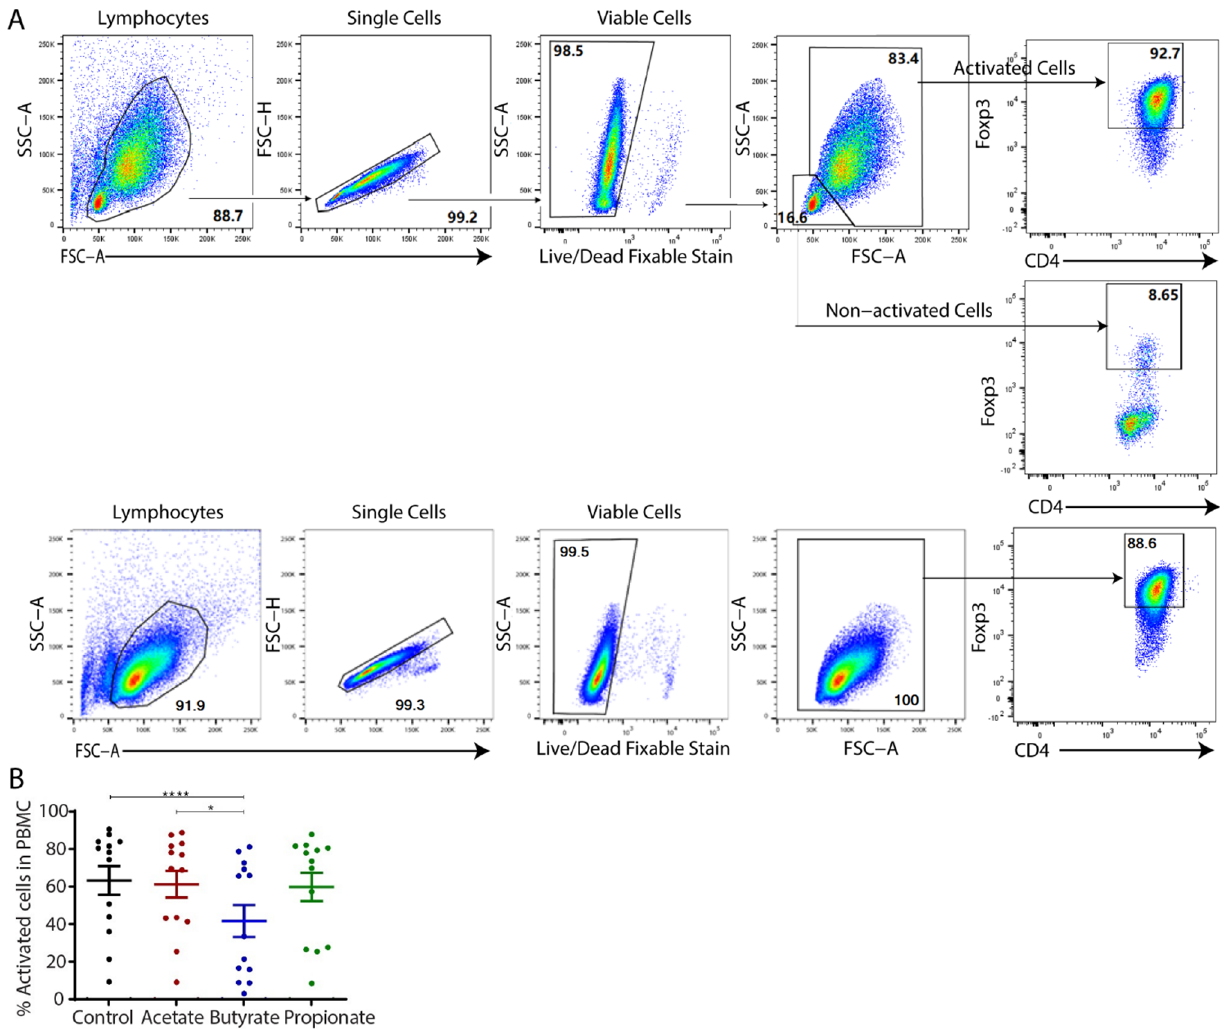
Figure 1. Differential activation patterns between adult and cord blood in the generation of human in vitro induced regulatory T cells (iTregs) in the absence or presence of short-chain fatty acids (SCFAs). ( A ) Flow cytometric gating strategy for activated cells gated on viable cells after Treg induction from adult PBMC (upper panel) and CBMC (lower panel) naïve CD4 + cells. ( B ) Scattered dot plot with the mean and standard error of the mean (SEM) showing the percentage of activated Fop3 + cells after induction from adult (left) naïve CD4 + cells under various conditions, summarizing thirteen independent experiments. Friedman test with Dunn’s multiple comparisons (post hoc) was used for statistical analysis. * p < 0.05, **** p < 0.0001.